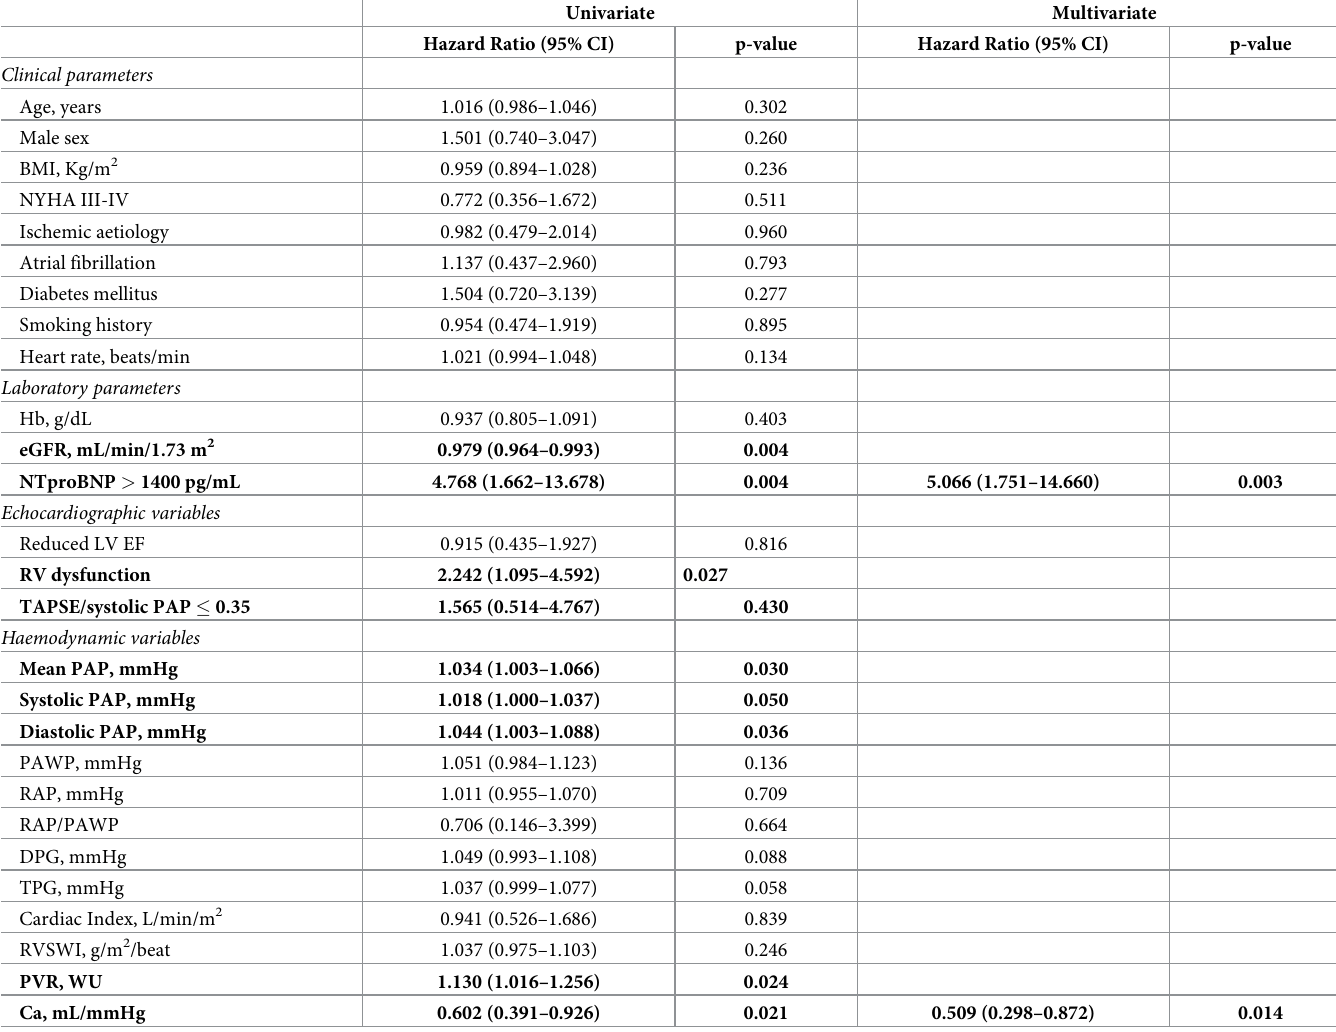
Table 5. Univariate and multivariate predictors of survival in pulmonary hypertension due to left heart disease.